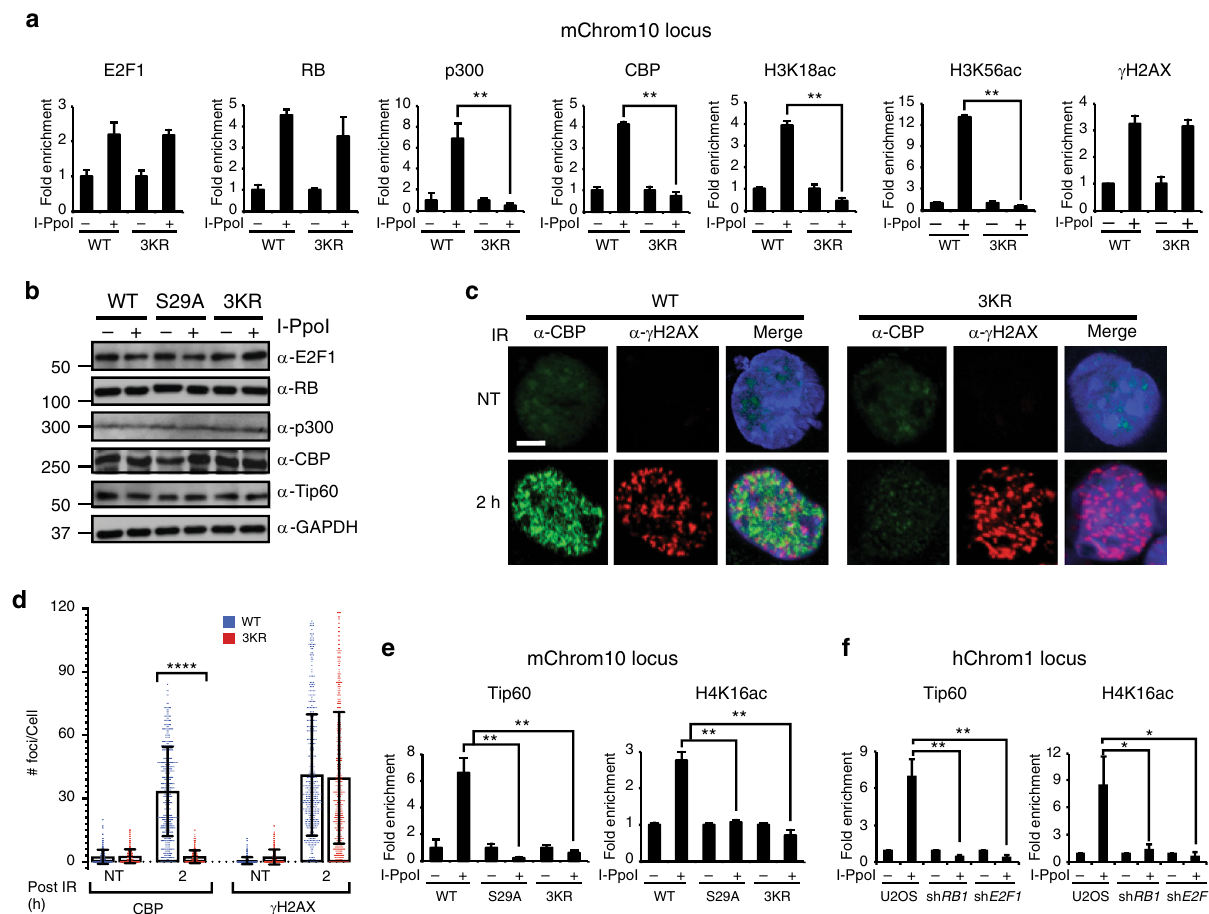
Fig. 5 The E2F1 3KR mutation impairs multiple histone acetylation events at DSBs. a Primary wild-type (WT) and E2f1 3KR/3KR (3KR) MEFs were subjected to the I-PpoI ChIP assay and qPCR was performed to determine the occupancy of the indicated proteins and H3 acetylation marks at mChrom10 locus. b Wild-type (WT), E2f1 S29A/S29A (S29A), and E2f1 3KR/3KR (3KR) MEFs were uninfected or infected with a retrovirus expressing inducible I-PpoI, treated with 4-OHT, and western blot analysis was performed for E2F1, RB, p300, CBP, Tip60, and GAPDH. c Wild-type and E2f1 3KR/3KR MEFs were mock treated (NT) or exposed to 5 Gy of IR 2 h prior to in situ extraction and fi xation. Representative images show formation of IR-induced foci for CBP (green) and γ H2AX (red) and merged with DAPI staining (blue) of nuclei. Bar, 10 μ m. d Quanti fi cation of CBP and γ H2AX foci. Each treatment group was in triplicate, and in total at least 450 cells ( n > 450) were counted per treatment group. Graphs represent average ± SD of foci per cell. Overlaid scattered dot plot shows the distribution of foci. P values were calculated by unpaired Mann – Whitney U test. **** P < 0.0001 is highly signi fi cant. e Primary wild-type (WT), E2f1 S29A/S29A (S29A), and E2f1 3KR/3KR (3KR) MEFs were subjected to the I-PpoI ChIP assay and occupancy of Tip60 and H4K16ac at mChrom10 locus was determined. f Parental U2OS cells and U2OS cells expressing shRNA to RB1 and E2F1 were subjected to the I-PpoI ChIP assay and qPCR was performed to determine occupancy of Tip60 and H4K16ac at hChrom1 locus. Except d , other graphs represent average ± SD of three independent experiments ( n = 3). P values were calculated by unpaired Student ’ s t test. ** P ≤ 0.01 is highly signi fi cant and * P ≤ 0.05 is signi fi cant. Source data of b is provided as Supplementary Data 5. Raw data of a and d – f are in Source data fi